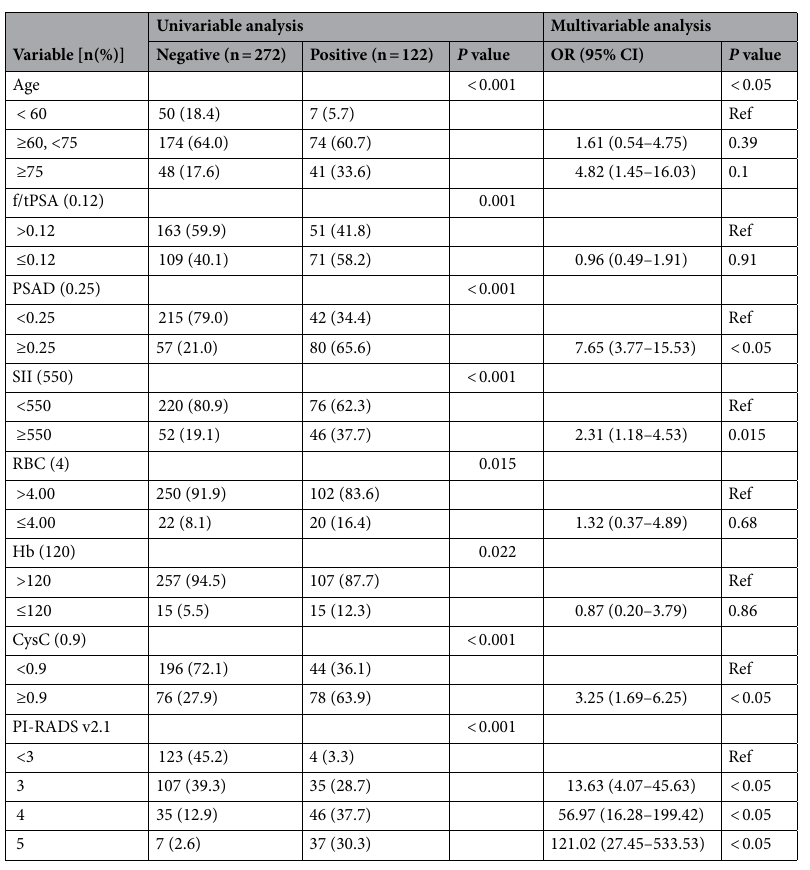
Table 2. Univariable and multivariable logistic regression analysis of factors associated with the outcomes of biopsy. OR odds ratio, PSA prostate-specific antigen, f/tPSA free/total PSA, PSAD PSA density, SII